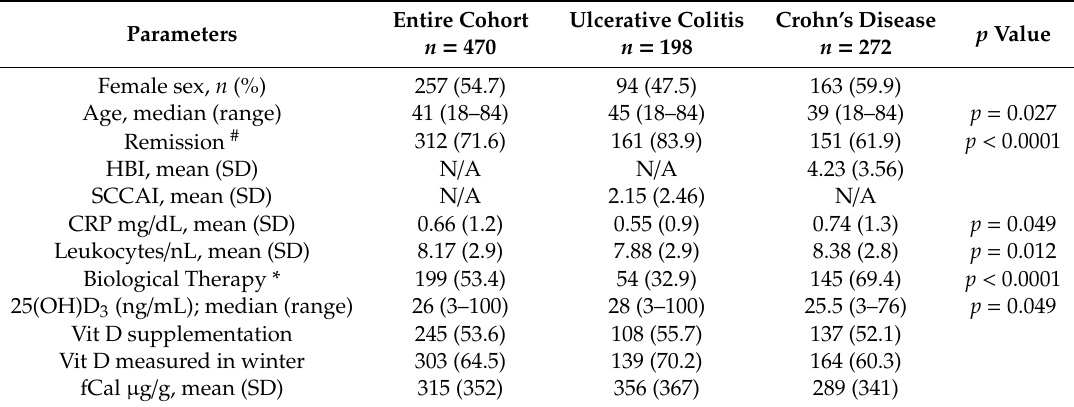
Table 1. Patient characteristics and group di ff